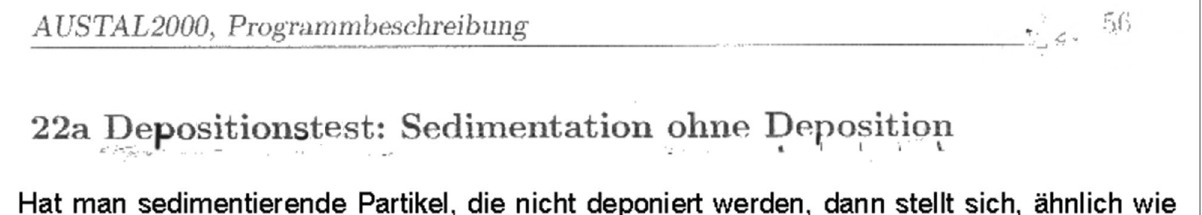
entire computing area” , which means that there are no spa- tial concentration gradients, ∂ c / x i = ∂ c / z = 0 . This sim- plifies Eq. (2) to Eq. (4). A simple integration with the initial condition c A = 0 gives the calculated value and Eq. (40).